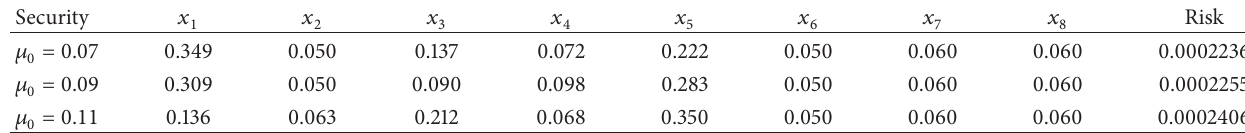
Table 2: The efficient portfolios with ℎ 0 = 1.8 .